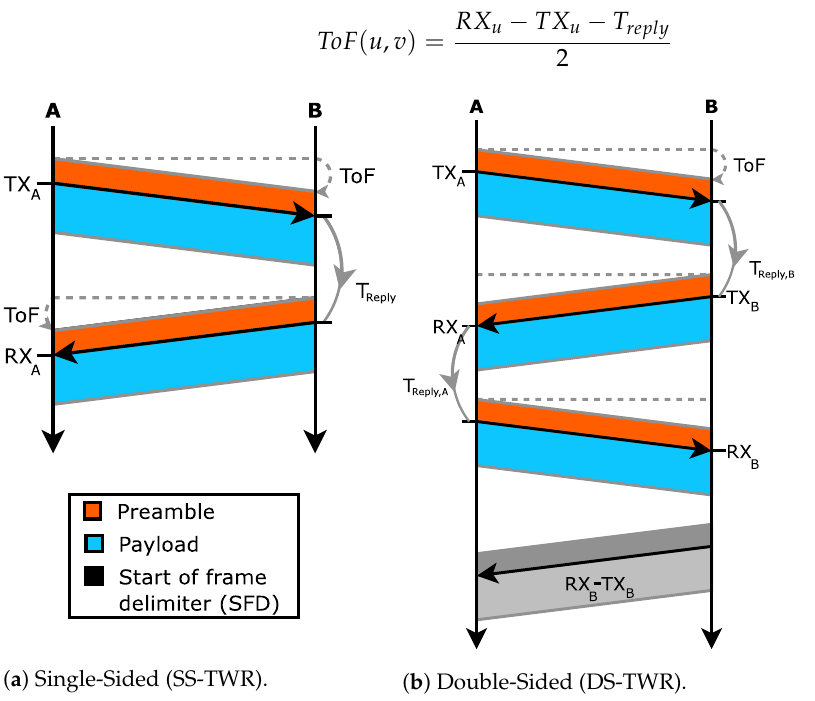
Figure 2. Principles of single-sided two-way ranging (SS-TWR) and double-sided two-way ranging (DS-TWR) protocols. Messages are composed of a preamble (orange) and payload (blue). A timestamp is associated to the end of the preamble. Times TX u , RX u and T Reply, u are measured with node u ’s clock